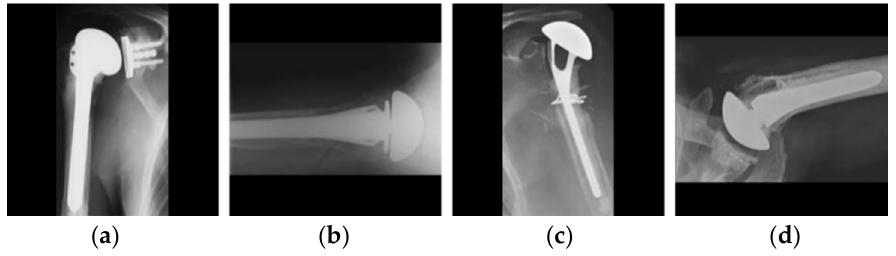
Figure 7. Examples of the dataset: shoulder implants of four different manufacturers: ( a ) Cofield, ( b ) Depuy, ( c ) Tornier, and ( d ) Zimmer.